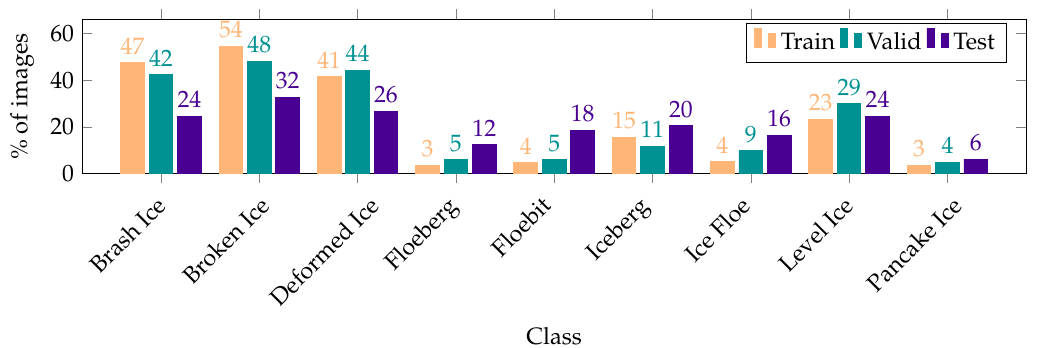
Figure 1. Class balance before the data has been resampled. The plot shows the percentage of the images in each dataset that contains the given class.